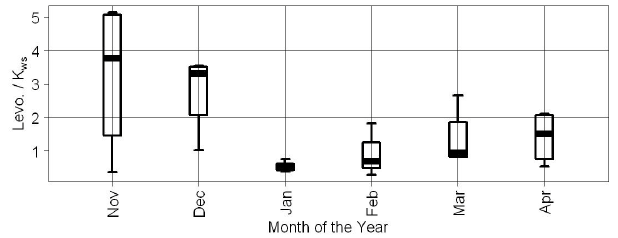
Fig. 4. Ratio of levoglucosan: K ws at Budbrooke according to month of